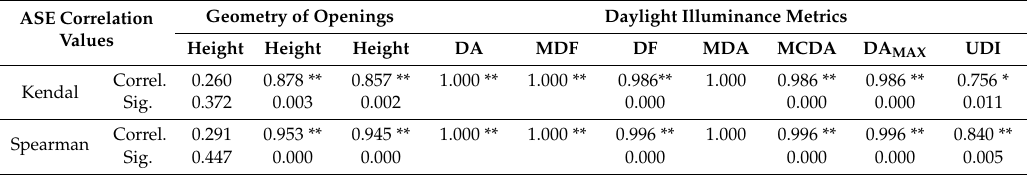
Table 9. Annual Sunlight Exposure Correlation